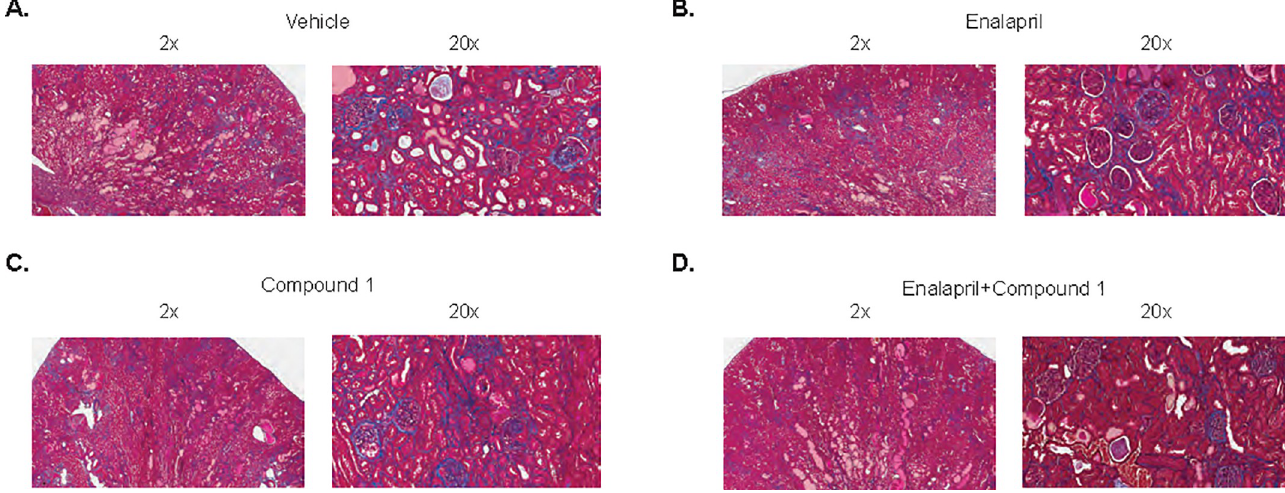
Fig 8. Representative histology imagines (Masson’s Trichrome). Trichrome imagines are proved at 2x and 20x magnification. (A) Vehicle treated; (B) Enalapril treated; (C) Compound 1 treated and (D) combination of enalapril and compound 1 treated groups.